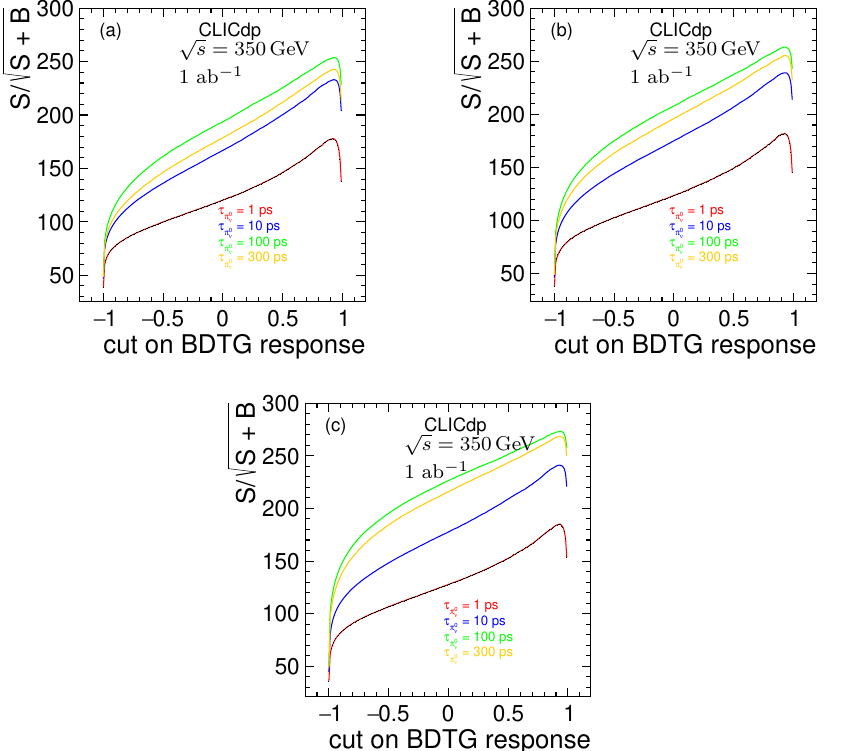
√ Figure 5 . Sensitivity S/ S + B for the expected number of events as a function of the cut on √ the BDTG response at s = 350 GeV, for signal samples of π 0 35 GeV/c 2 and (c) 50 GeV/c 2 , and for four different lifetimes: 1 ps (red line), 10 ps (blue line), 100 ps (green line) and 300 ps (yellow line). An integrated luminosity of 1 ab − 1 at √ and 3 ab − 1 at s = 3 TeV has been